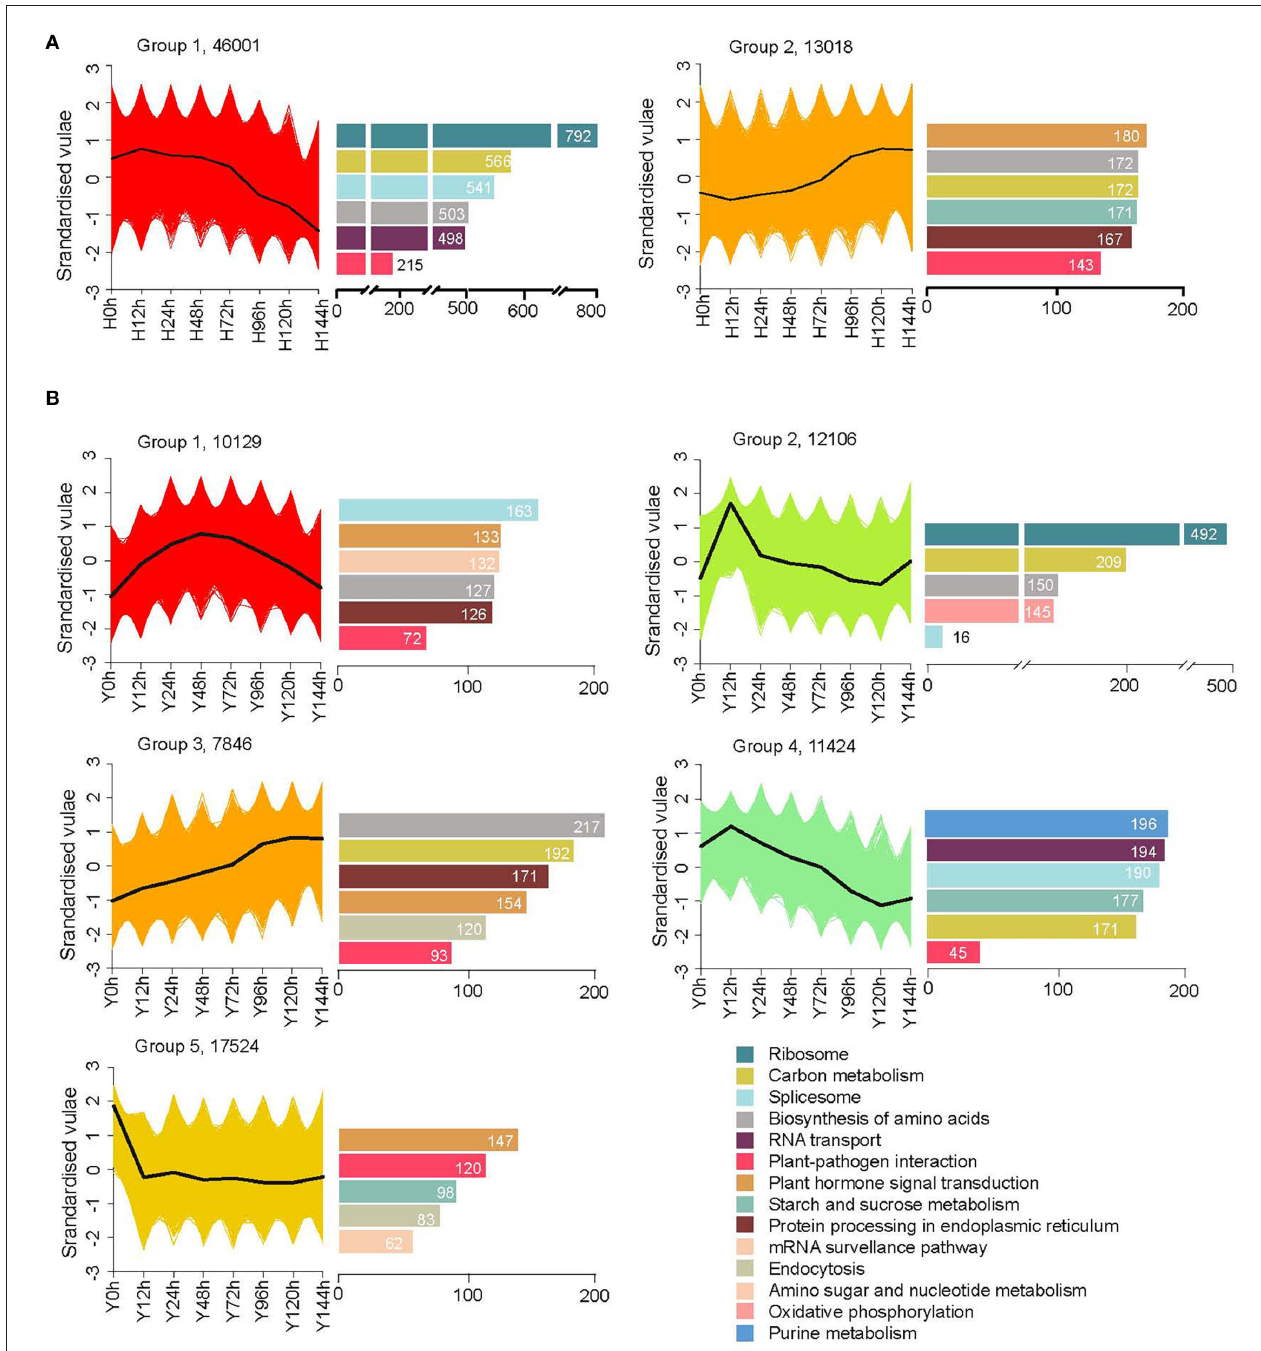
FIGURE 3 | More sophisticated expression patterns in the resistant cultivar Y (B) than the susceptible cultivar H (A) . Cluster assignments of genes with FPKM ≥ 1 are shown in the left graph and, correspondingly, the top five KEGG enriched pathways as well as the “plant–pathogen interaction” pathway are shown in the right bar